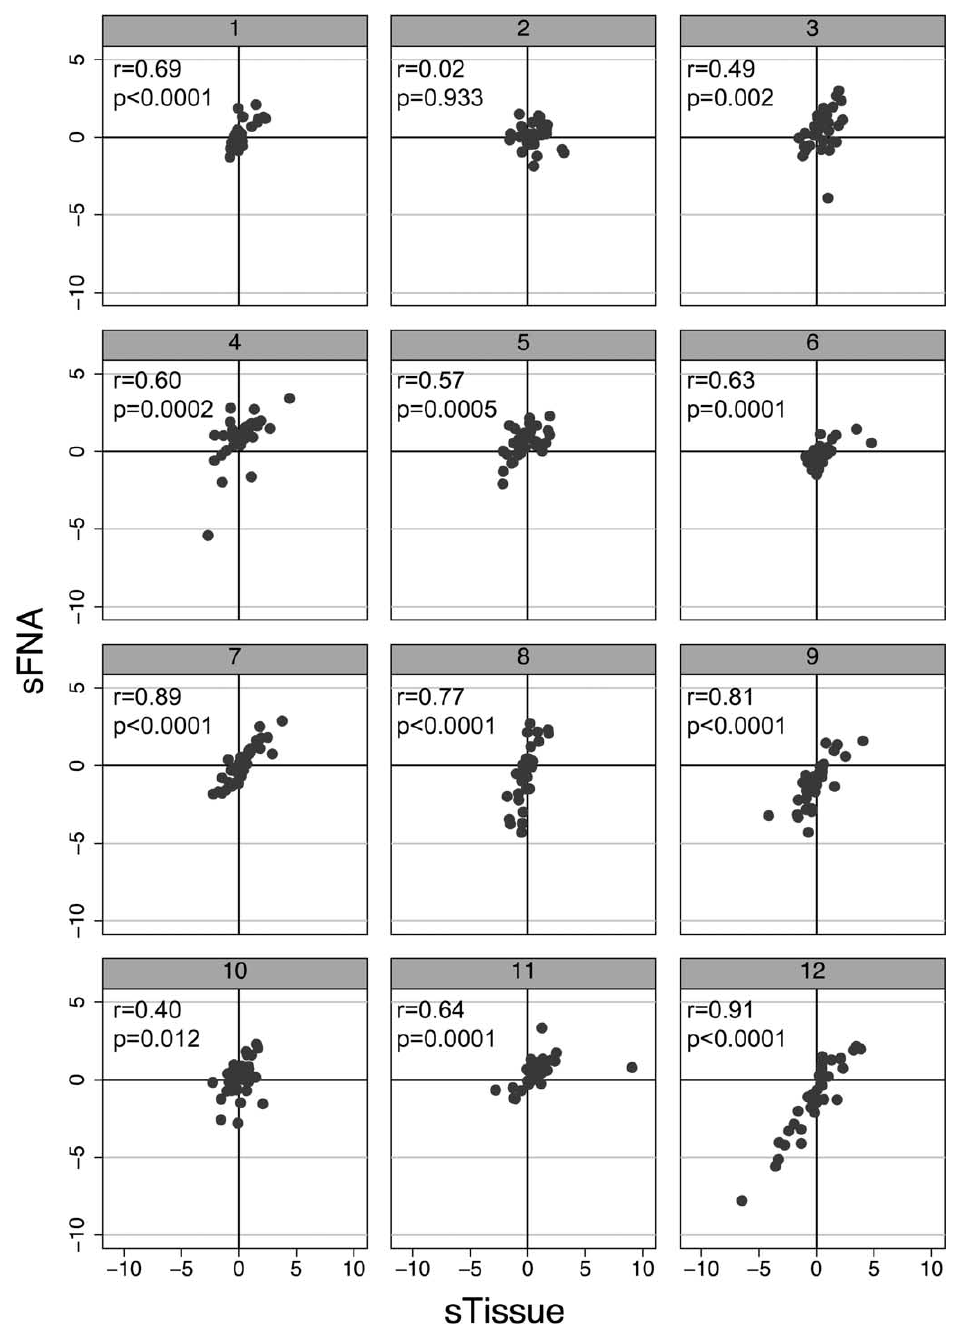
Fig. 3. Scatterplot and Spearman Correlations between the gene expression profiles obtained by FNA (averaged of FNA-A and FNA-B (sFNA)) and gene expression profiles obtained by tissue biopsy (sTissue) per patient. Only patient no. 12 was ER − ; the remaining were 100% ER+. using immunohistochemistry [6,15,19]. This under- ple, ER, PgR and ERBB2/HER2 showed significant scores one of the difficulties in using single genes as heterogeneity in 42–66% of patients ( p < 0 . 05, t -test), markers, i.e., they are prone to false which parallels earlier observations at the protein level